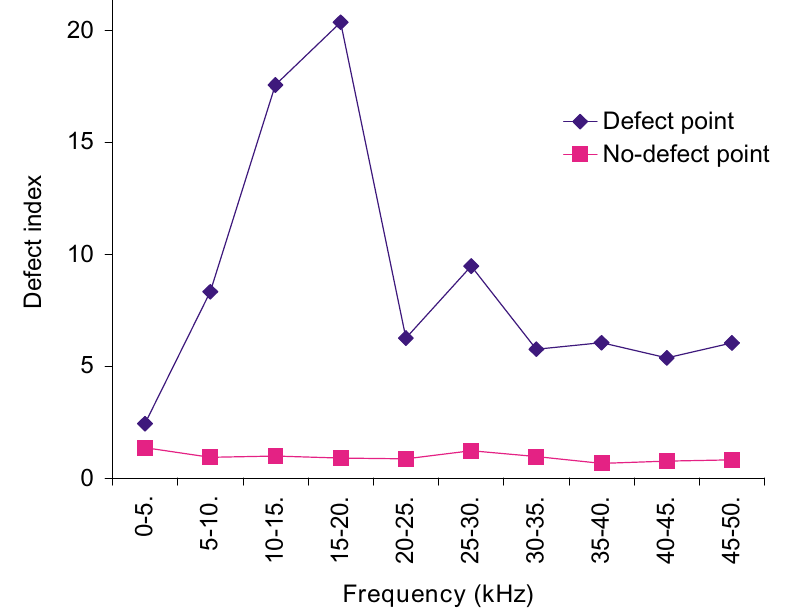
Fig. 18. Comparison between Damage Index for a defected and a non-defected point in the icon.